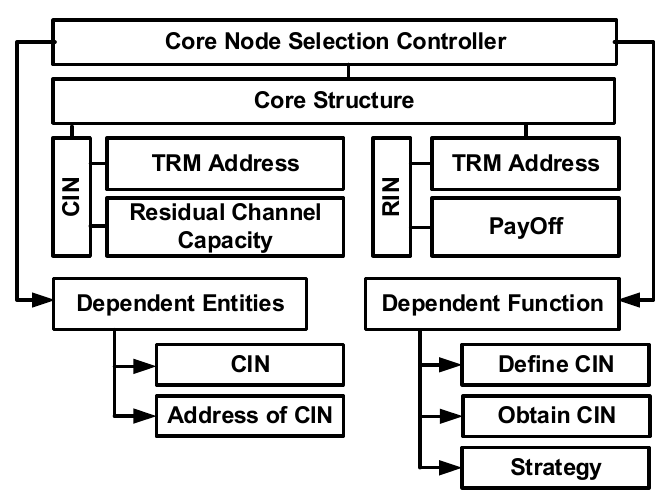
Figure 3. Dependent entities and function of GTC.